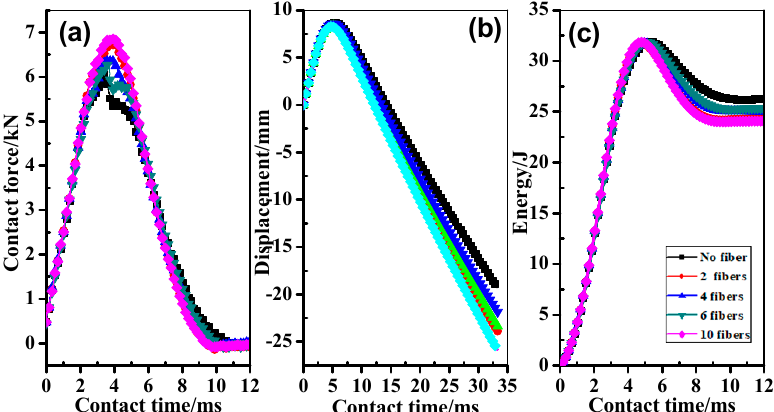
Figure 6. Typical graphs of laminates with one layer of SMAs located at different positions after impact: ( a ), ( b ), and ( c ) are the contact force-time ( F - t ) curves, displacement-time ( D - t ) curves, and energy-time ( E - t ) curves, respectively.